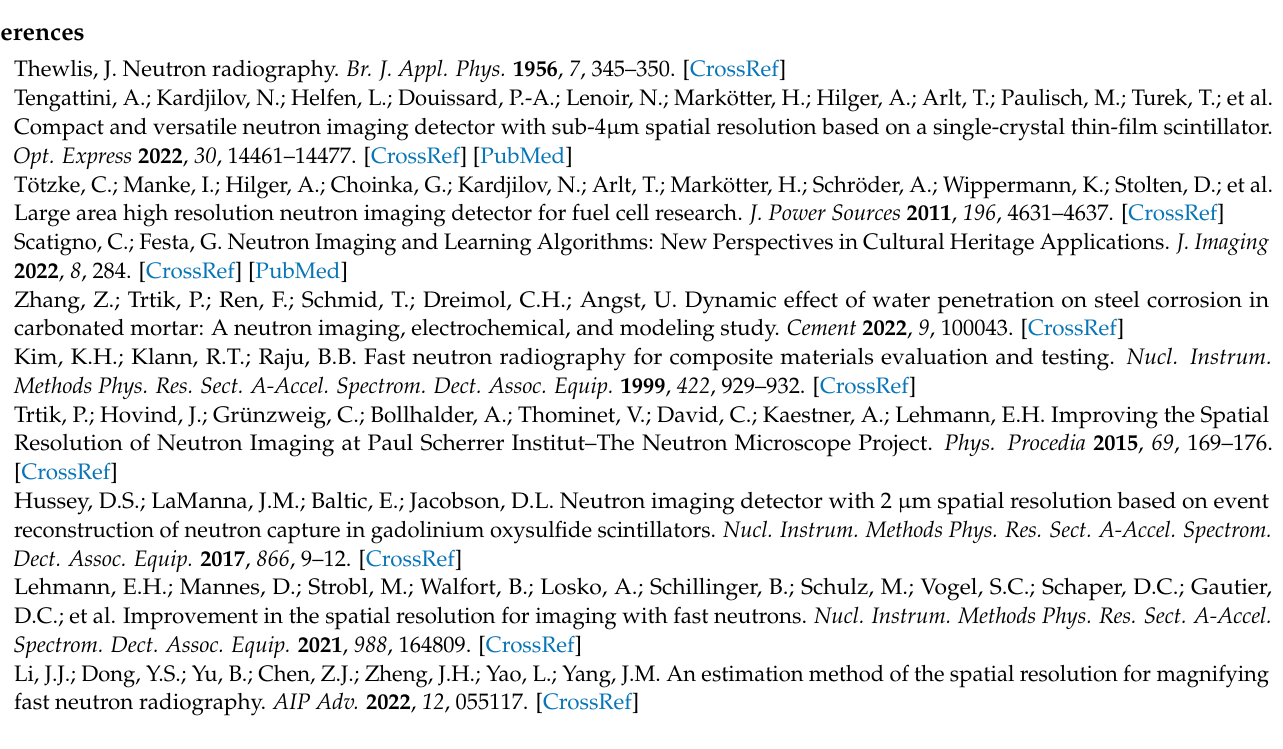
scintillator; Figure S2: Incident cold neutron spectrum; Table S1: The elemental mass ratio of